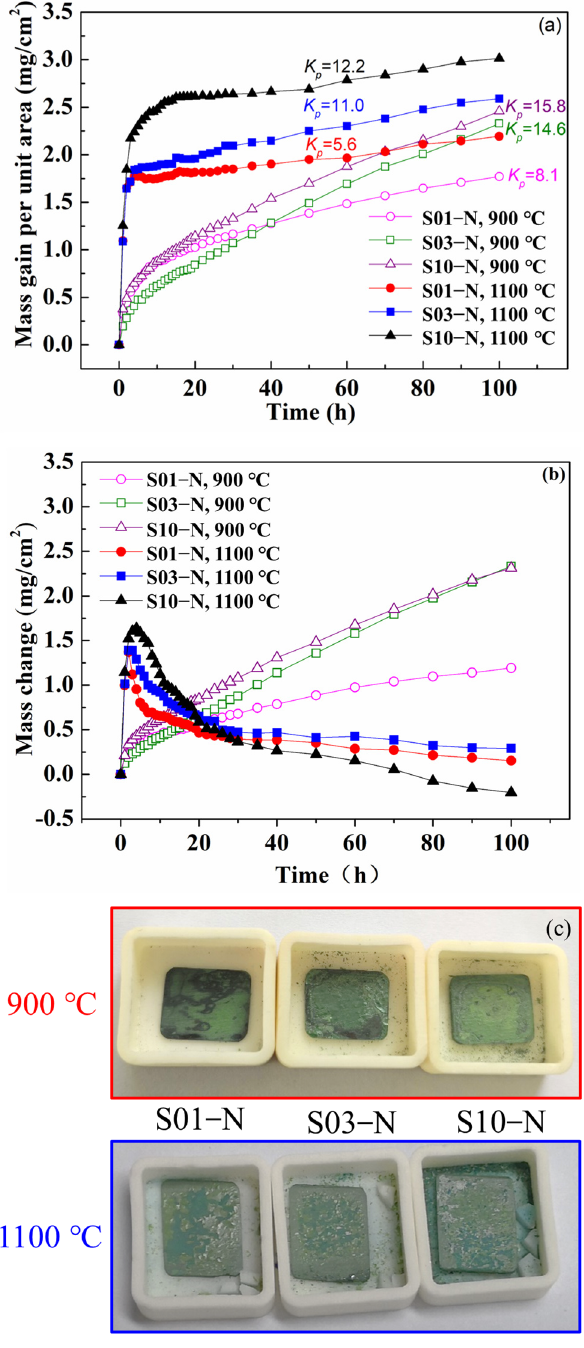
Figure 2. Cyclic oxidation kinetic curves of the specimens of IC21 alloy with different thicknesses at 900 °C and 1100 °C: ( a ) mass gain; ( b ) mass change. Parabolic rate constant k p is also calculated according to Equation (2) and shown in ( a ) with a unit of 10 − 12 g 2 · cm − 4 · s − 1 ; ( c ) macrostructure after 100 h cycle oxidation at 900 °C and 1100 °C.